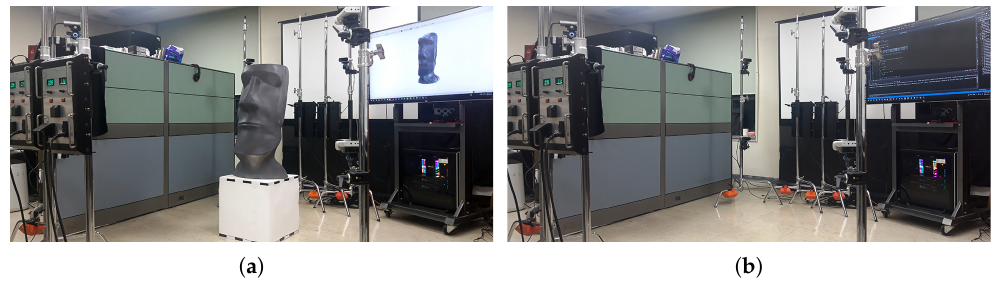
Figure 7. Experimental environment ( a ) capturing, ( b ) camera